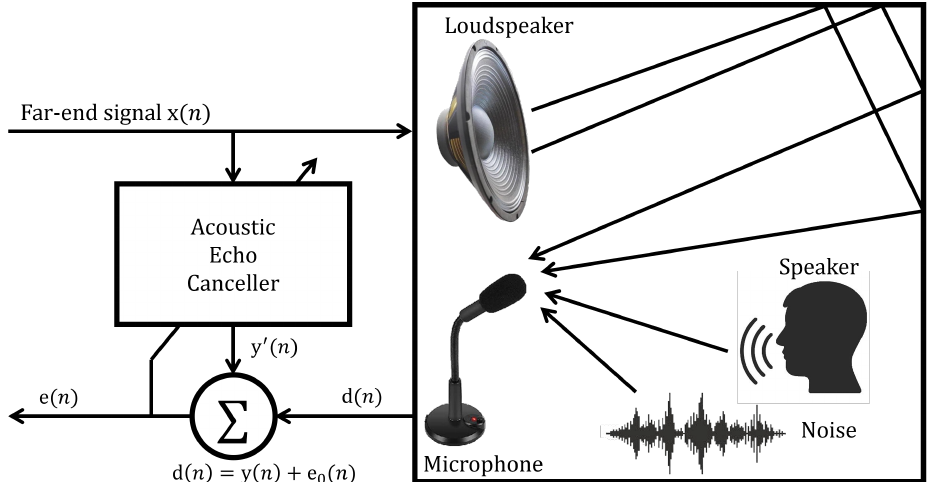
Figure 3. Structure of the acoustic echo